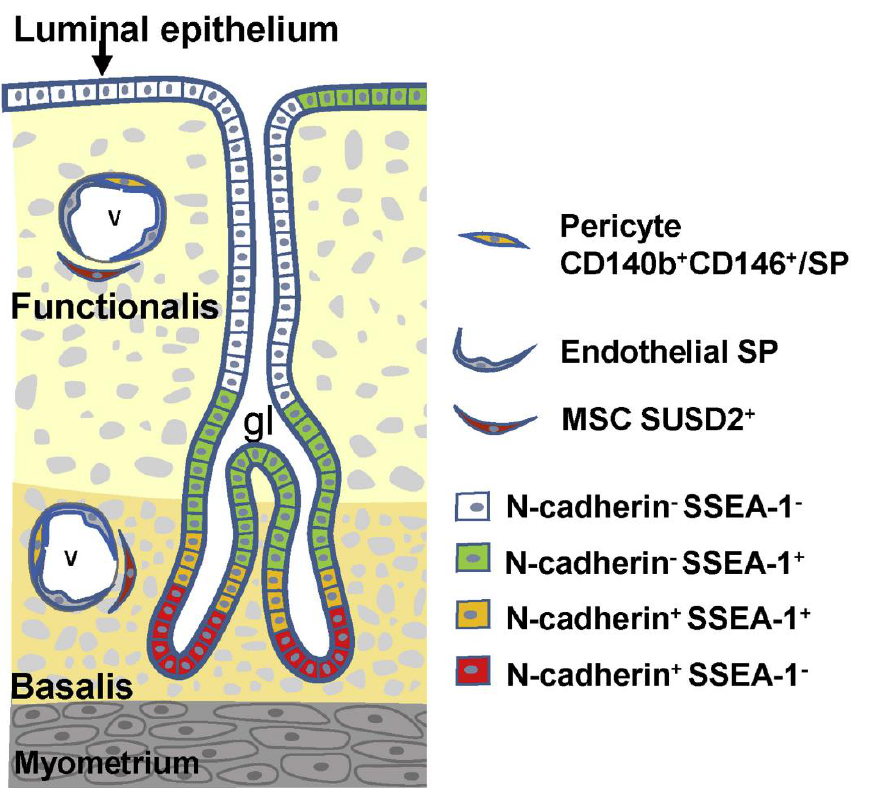
Figure 1. Localization and markers of human endometrial stem/progenitor cells. Endometrial stromal (mesenchymal) stem/progenitor cells are divided into three types: (1) pericytes doubly positive for CD140b and CD146 or those with SP phenotype, (2) endothelial SP, and (3) perivascular SUSD2 + (sushi domain-containing 2) cells. Endometrial epithelial stem/progenitor cells are divided into at least four types based on the expression pattern of N-cadherin and SSEA-1 (stage specific embryonic antigen-1). There may exist an epithelial cell hierarchy in which N-cadherin + SSEA-1 − cells (red) are the most primitive, followed by a hierarchy as follows: N-cadherin + SSEA-1 + , N-cadherin − SSEA-1 + , and N-cadherin − SSEA-1 − . The surface markers of endometrial epithelial stem/progenitor cells have been further characterized in detail [20]. Reproduced from [19] with permission from Elsevier